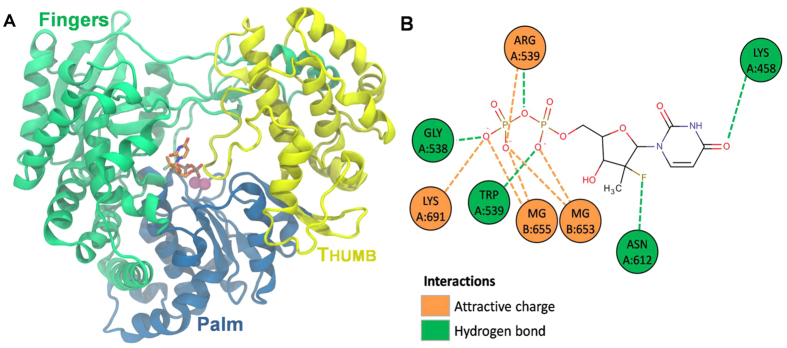
Putative ZIKV RNA polymerase in complex with sofosbuvir.Based on the crystal structure of the HCV RNA polymerase in complex with sofosbuvir diphosphate (PDB accession #4WTG), the putative structure of the ZVRP was constructed. Using the T-COFFEE server, the amino acid sequence of the ZVRP (UniProtKB ID: B3U3M3) was aligned with orthologous RNA polymerases from other members of the Flaviviridae family, specifically hepatitis C virus (HCV; PDB #4WTG, West Nile virus (WNIV; PDB #2HFZ), Japanese encephalitis virus (JEV; PDB #4K6M), and dengue virus (DENV; PDB #5DTO). The MODELLER 9.16 software was used to build a 3D model of ZIKV RNA polymerase, with subsequent refinement performed using three cycles of the default optimization protocol. The structural evaluation of the model was performed using two independent algorithms, PROCHECK software and VERIFY 3D. (A) The 3D model of ZIKV RNA polymerase is presented. (B) The residues presumably required for the interaction of ZVRP with sofosbuvir and Mg++ ions.